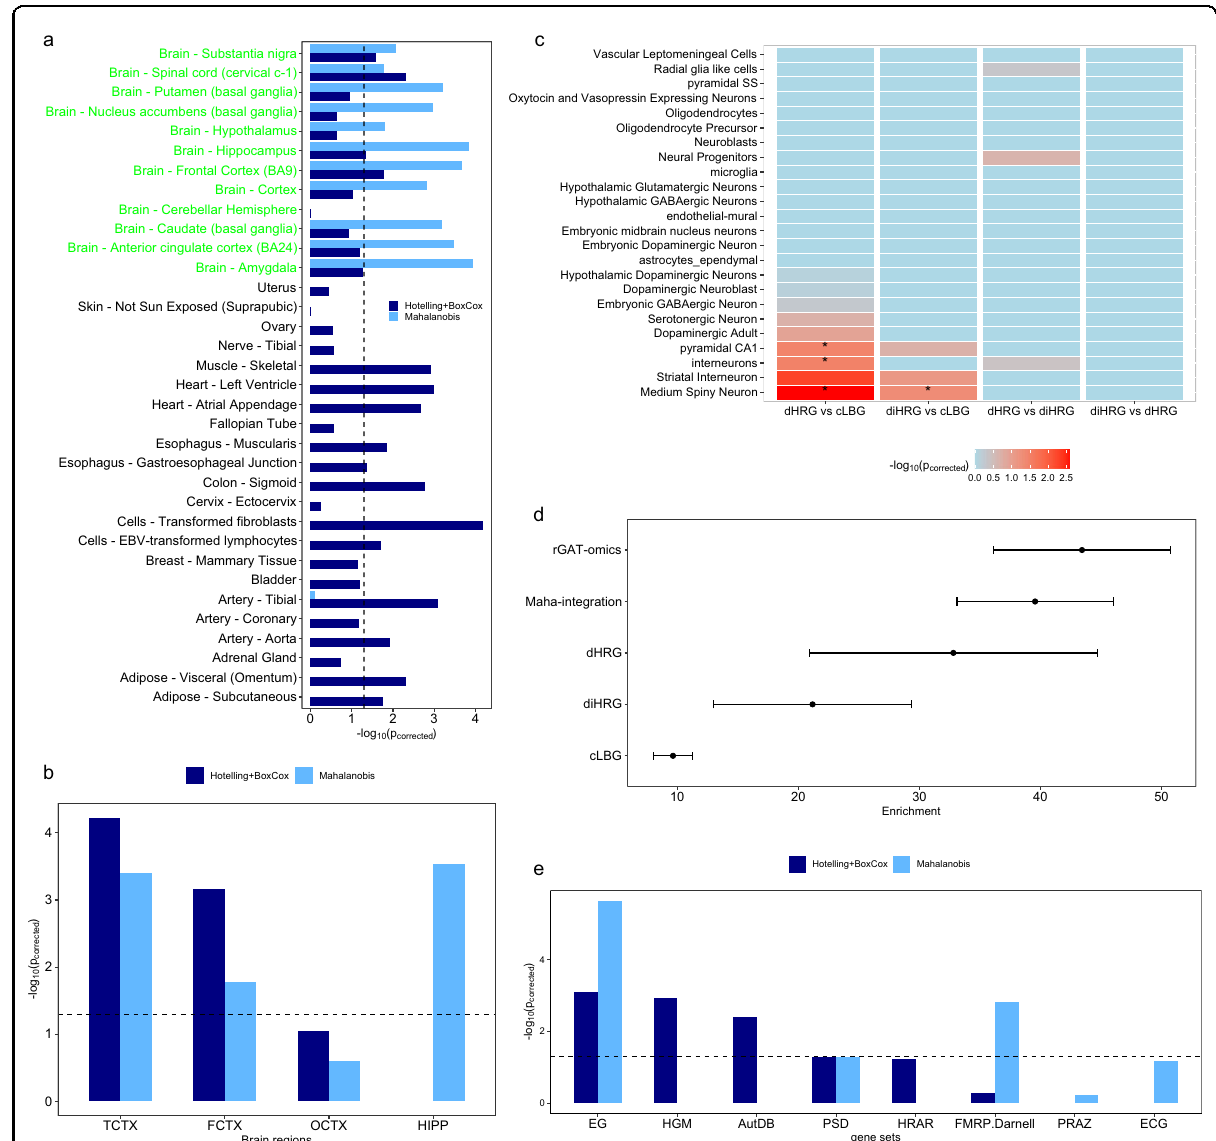
Fig. 2 Comparing dHRGs and diHRGs in terms of tissue speci fi city, SCZ-related gene set enrichment, and cell speci fi city. a In GTEx data, diHRGs ( n = 25) were highly expressed in 11 brain tissues, whereas dHRGs ( n = 25) were highly expressed in four brain tissues compared to cLBGs ( n = 641). Tissues names in green indicate brain tissues. b Compared to cLBGs, diHRGs were highly expressed in three brain regions, whereas dHRGs were highly expressed in two brain regions. c The cell-speci fi city analysis showed that dHRGs were speci fi cally expressed in four cell types and three were associated with SCZ, whereas diHRGs were speci fi cally expressed in one cell type and it was SCZ related compared to cLBGs. “ * ” denotes SCZ related cell type. dHRGs or diHRGs showed no signi fi cant variation in expression in any SCZ-related cell type compared to diHRGs or dHRGs. “ dHRG vs cLBG ” represents cell-speci fi city analysis on dHRGs using cLBGs as background genes; “ diHRG vs cLBG ” represents cell-speci fi city analysis on diHRGs using cLBGs as background genes; “ dHRG vs diHRG ” represents cell-speci fi city analysis on dHRGs using diHRGs as background genes; “ diHRG vs dHRG ” represents cell-speci fi city analysis on diHRGs using dHRGs as background genes. d The HRGs predicted by rGAT-omics represent a higher proportion of SCZ heritability compared to the HRGs predicted by Maha integration. Moreover, dHRGs explained higher proportion of SCZ heritability than diHRGs and cLBGs. The center values represent the enrichment and the error bars indicate standard errors. e dHRGs were signi fi cantly enriched in four gene sets, while diHRGs were enriched in three gene sets compared to